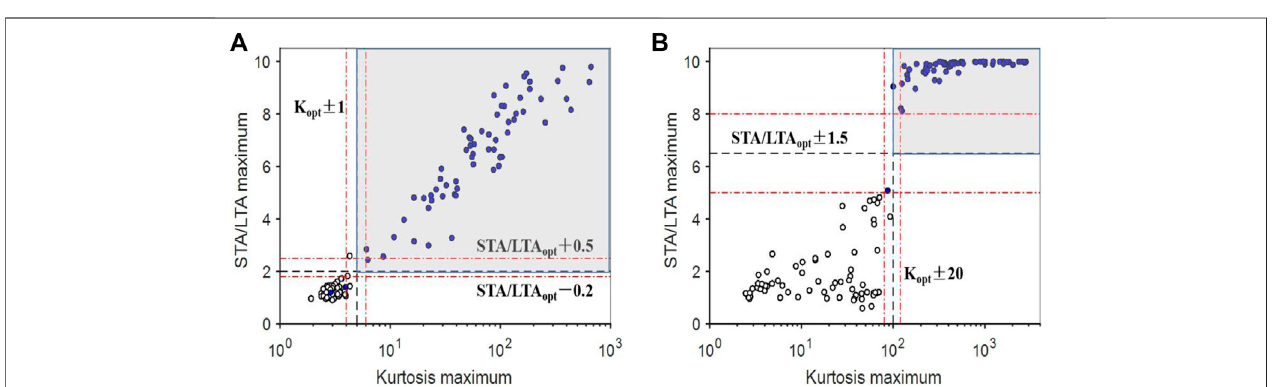
FIGURE 9 | Comparison of the robustness of automatic microseismic event detection before and after denoising. White dots indicate noise measurements, blue dots correspond to microseismic events. (A) Results of Original training data set, dark dashed lines indicate the selected optimal threshold level of maximum kurtosis (K opt =5), and maximum STA/LTA (STA/LTA opt =2), and red dashed lines indicate the selected optimal threshold level range of kurtosis (K opt ± 1) and STA/LTA (STA/ LTA opt - 0.2 and STA/LTA opt + 0.5). (B) Results of denoising data set, dark dashed lines indicate the selected optimal threshold level of maximum kurtosis (K opt =100), and maximum STA/LTA (STA/LTA opt = 6.5), red dashed lines indicate the selected optimal threshold level range of kurtosis (K opt ± 20) and STA/LTA (STA/ LTA opt ±